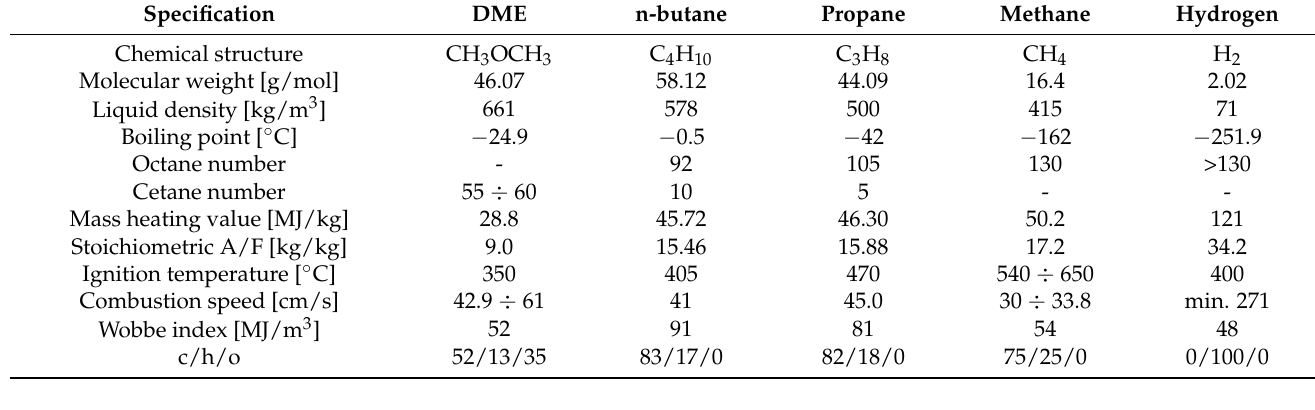
Table 2. Physical and chemical properties of DME and similar, other fuels [20,21].